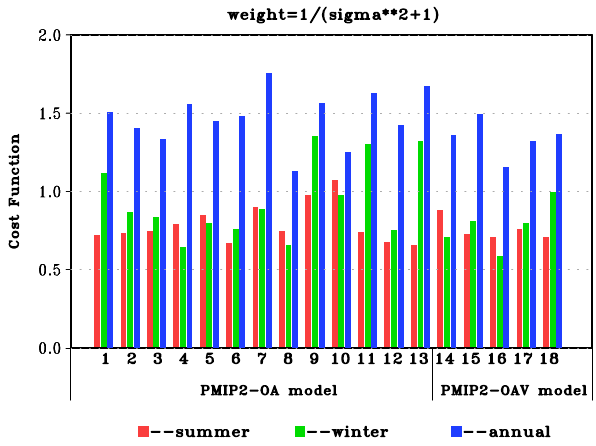
Fig. 5. Value of the cost function for the 18 PMIP2 models for summer temperature (red), winter temperature (green), annual mean temperature (blue). The value of the cost function is normalized by the number of the reconstructions. The horizonal X-axis indicates the 18 PMIP2 models used in the comparison. Number 1 to 13 are PMIP2-OA models: 1, CCSM; 2, CSIRO-Mk3L-1.0; 3, CSIRO- Mk3L-1.1; 4, ECBILTCLIOVECODE; 5, ECHAM5-MPIOM1;